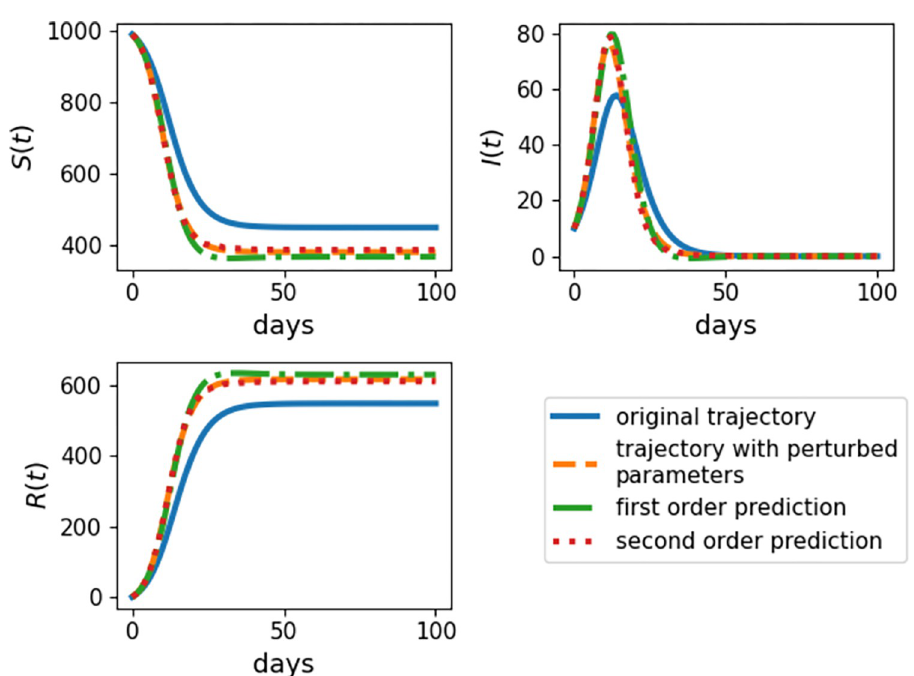
Fig 4. Model Trajectories for SIR Model Calculated Using First and Second Differentials. Time series plot of the SIR model simulated over t = 100 days with initial conditions S 0 = 1000 and I 0 = 10. Results depend on the SIR model with the original parameters from Fig 3 (original trajectory), re-simulating the SIR trajectory after perturbing the parameters by a random amount around 25% (trajectory with perturbed parameters), approximating the trajectory based on the linear expansion (Eq 5) and the first derivative calculated with the complex perturbation method (first- order prediction), and approximating the trajectory based on the quadratic expansion (Eq 4) and the first and second derivatives calculated with the complex perturbation method (second-order